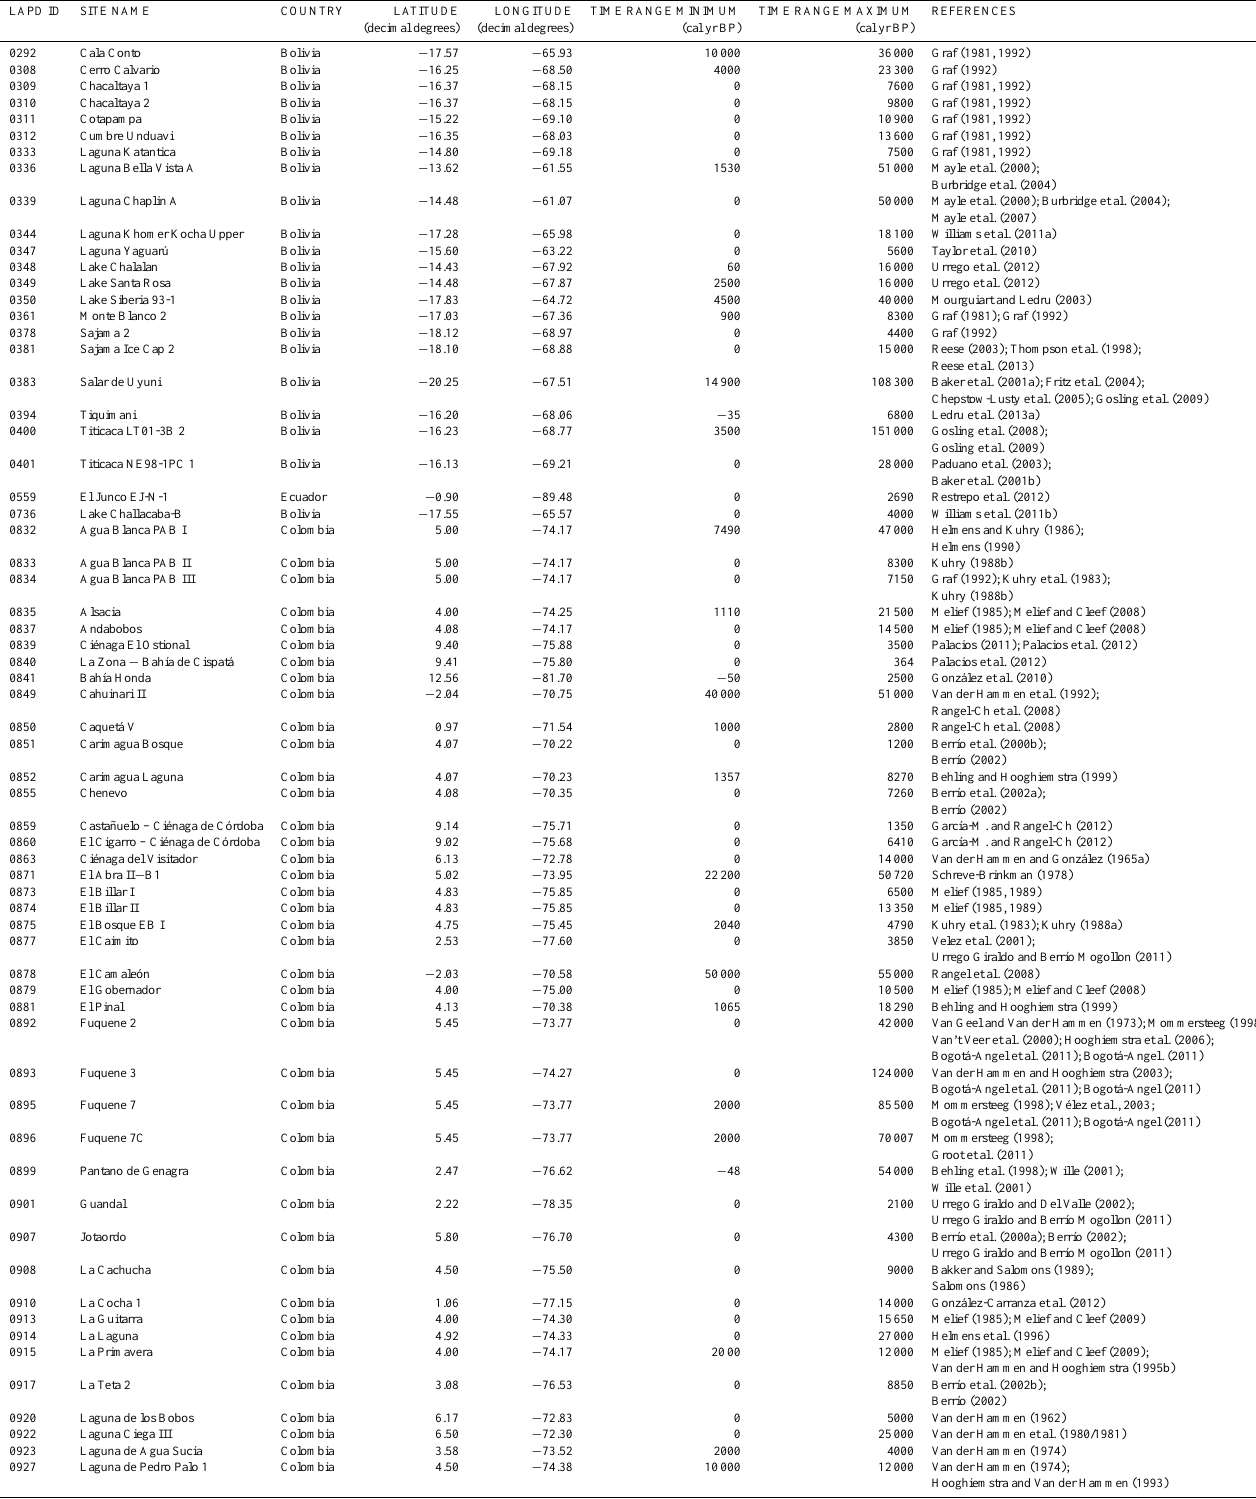
Table 1. List of sites for which age models were recalibrated. LAPDID